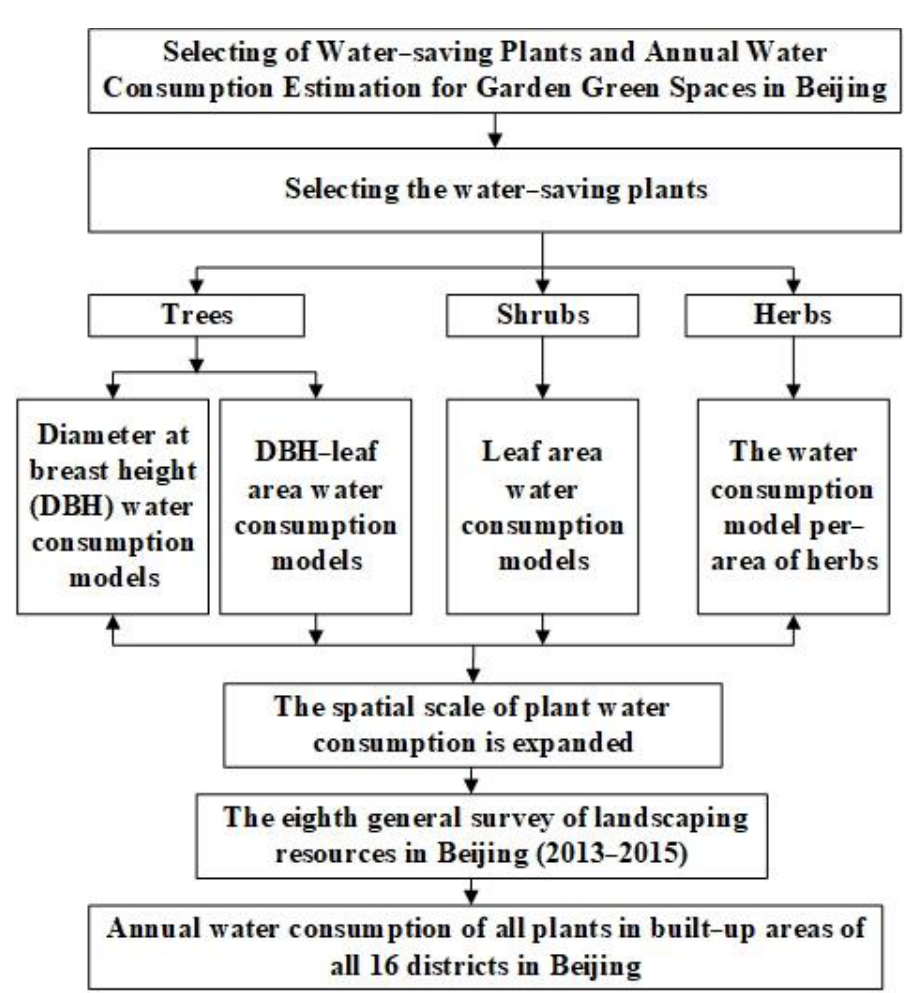
Figure 1. The research structure diagram.